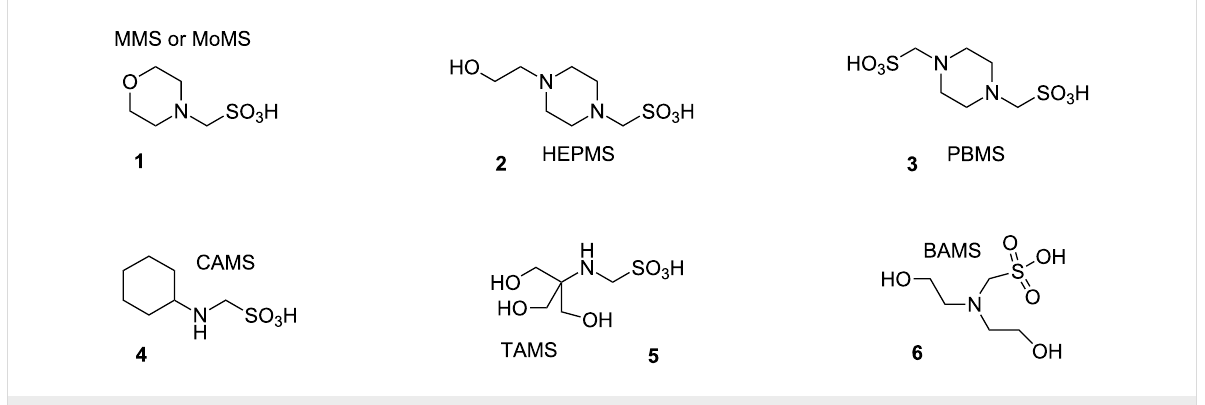
Figure 2: Aminomethanesulfonic acids in this study and their proposed